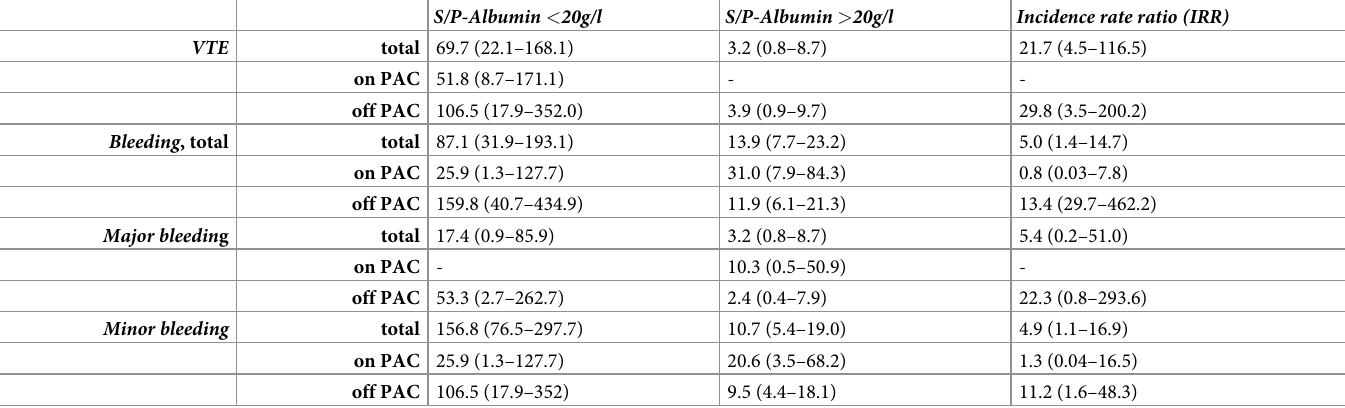
Table 4. Rate of outcomes in two S/P-albumin